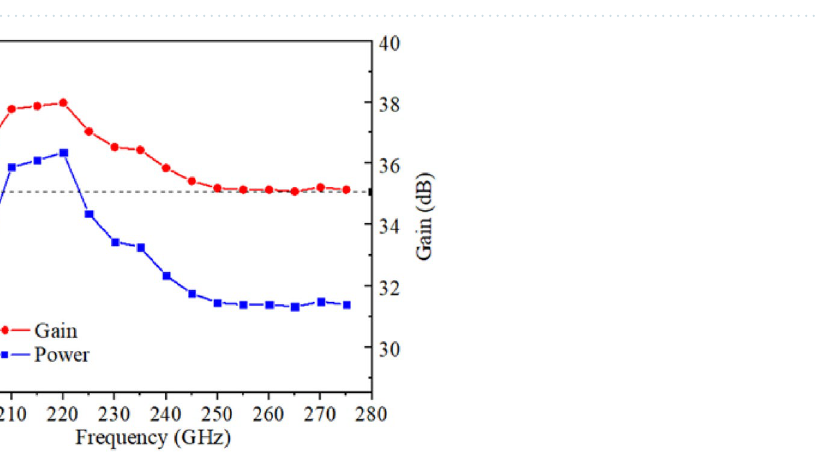
Figure 22. Output signal of SDV-SWS at 220 GHz. ( a ) Output power with frequency spectrum inside. ( b ) Energy distribution of electrons with the electron bunching at the end of the SWS inset.